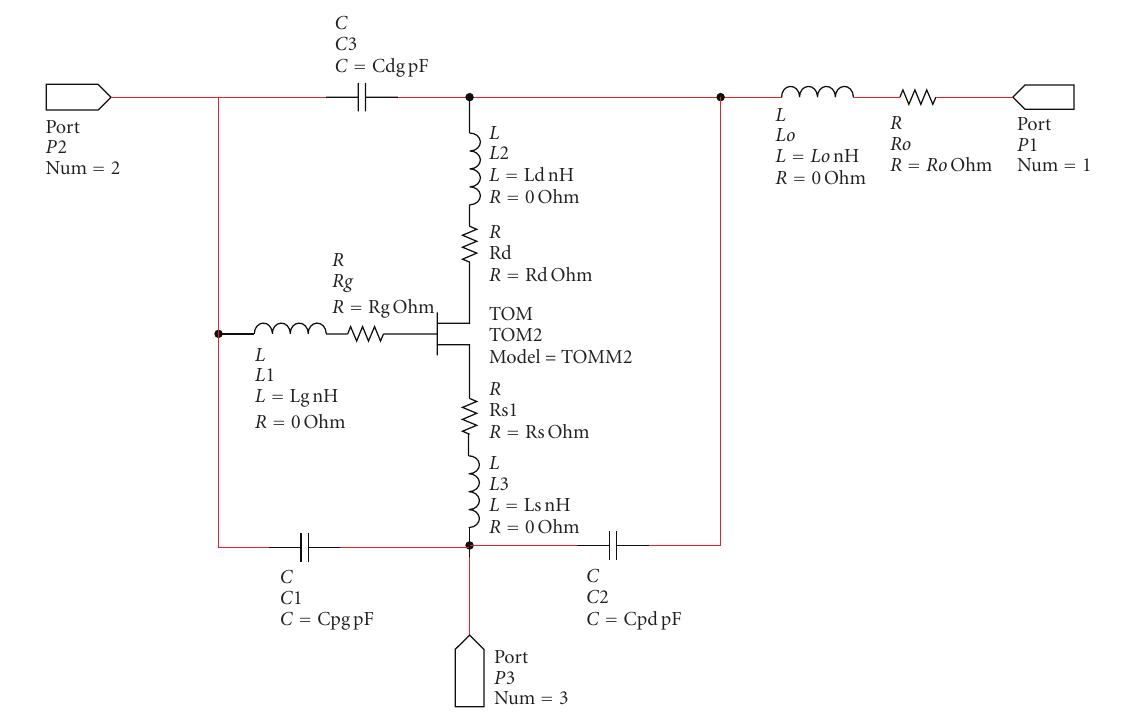
Figure 2: Improved model taking into account the parasitic e ff ects of the package.